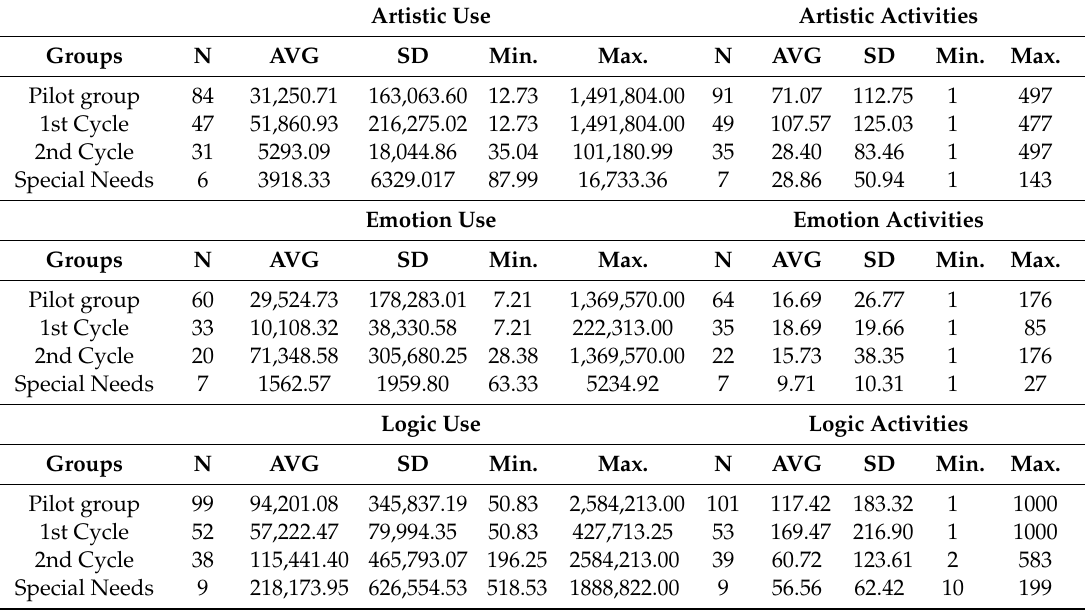
Table A5. Descriptive statistics of the Pilot Group 3 at platform worlds. The use is measured in seconds and the activities done are collected as